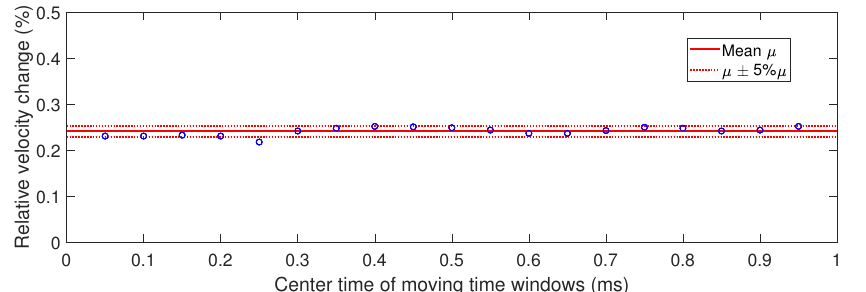
Figure 5. Relative velocity change calculated at different time window locations, between two signals collected at the 75th and 80th